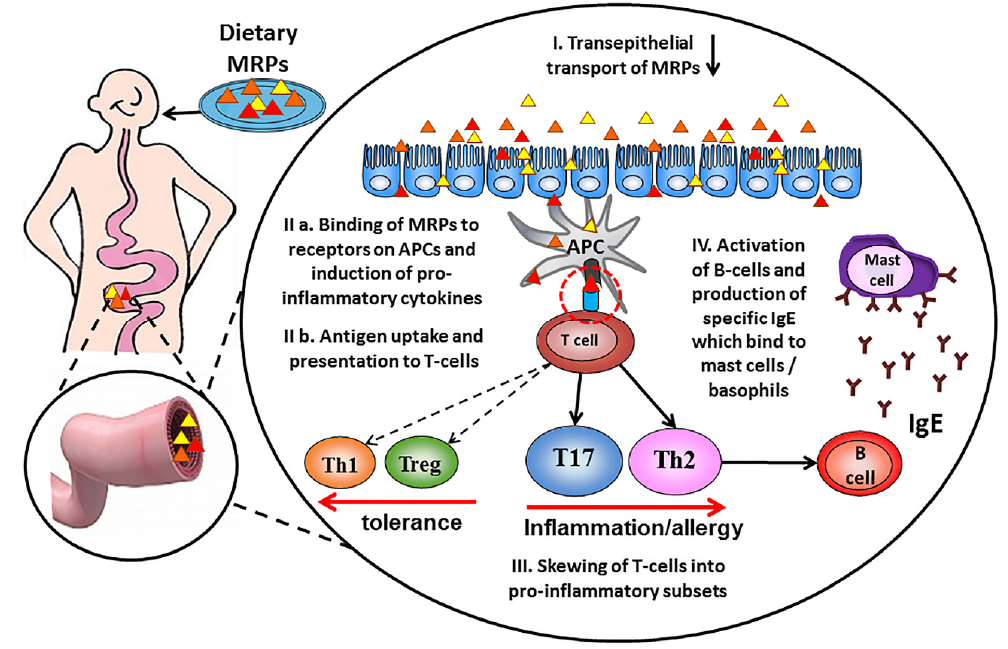
Figure 2. Schematic contribution of dietary Advanced glycation end products in the allergic sensitization process. Dietary Maillard reaction products (MRP) are taken up in the gut by crossing the epithelial barrier (I), leading to antigen uptake by mucosal dendritic cells and presentation of peptides to specific T ‐ cells (II). Activated antigen ‐ specific helper Th cells differentiate into pro ‐ inflammatory and allergy ‐ inducing Th17 and Th2 subsets (III). Allergen ‐ specific B ‐ cells become activated upon ligand binding and start the production of allergen ‐ specific IgE antibodies (IV) that bind to mast cells and basophils and become detectable in the